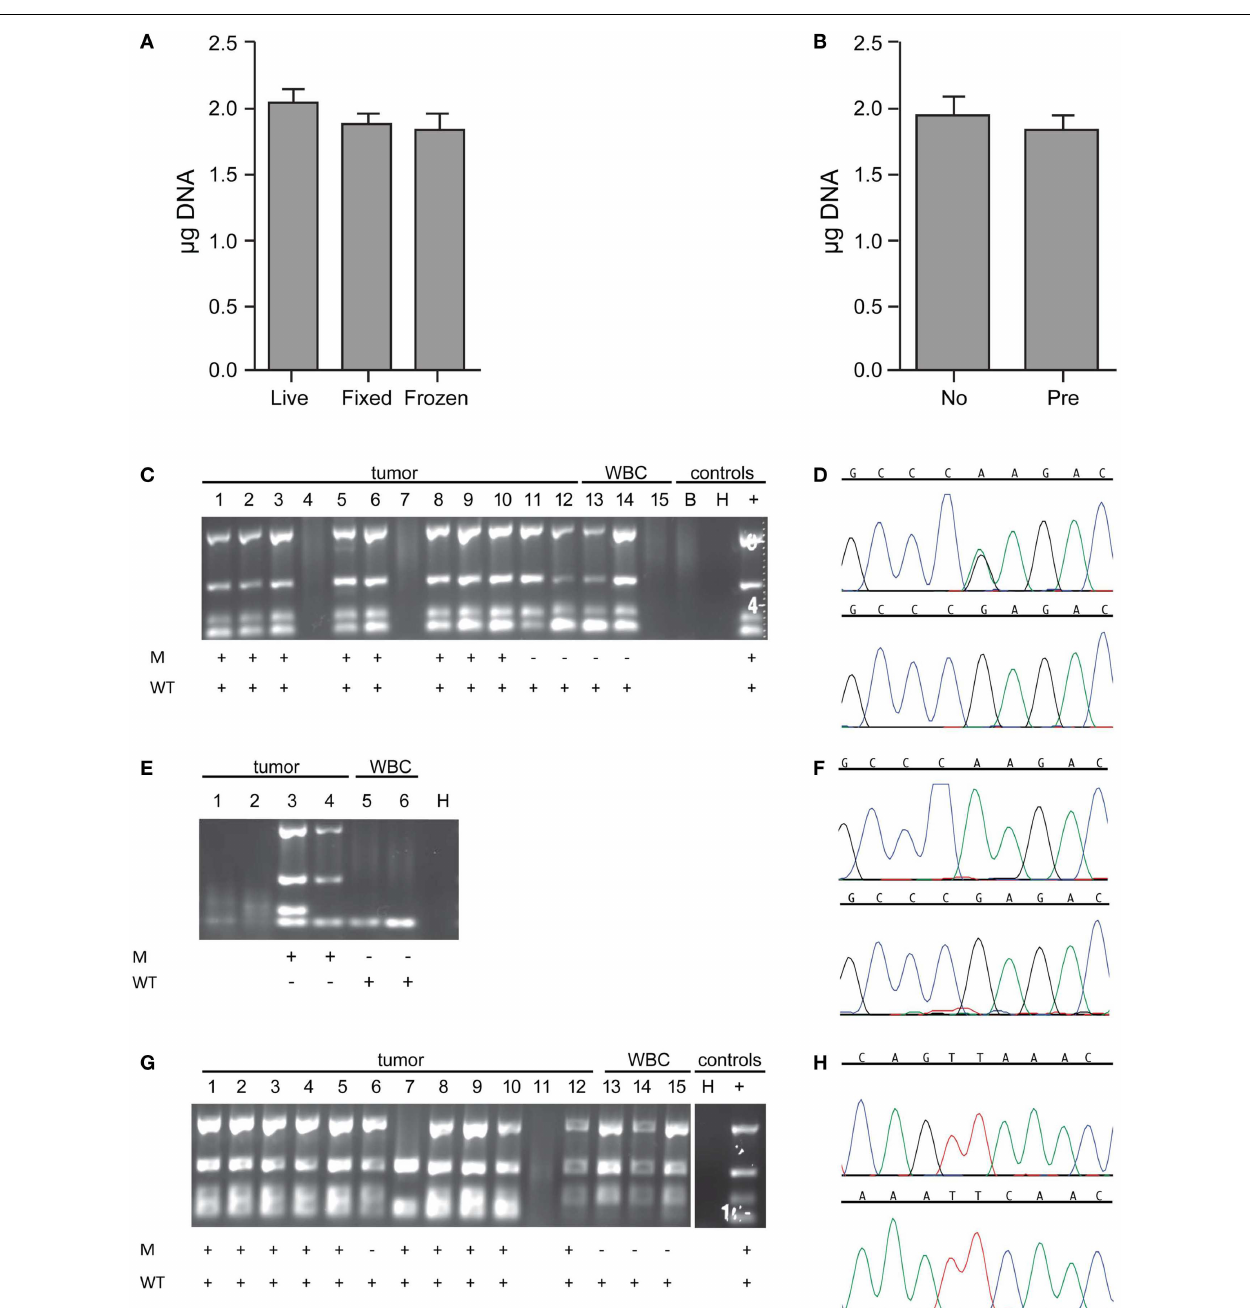
pre-labeled, single cells collected by DEPArray, DNA extracted, andWGA performed.WGA product was subjected to a quality control step in which bands for 4 housekeeping genes were visualized, as shown for 12 single heterozygous NB1643 tumor cells (columns 1–12), 3WBCs (columns 13–15), a no-cell “blank” (B), a water control (H), and positive control genomic NB1643 DNA ( + ). Detection of the mutant allele is denoted by “ + ” in row M, and detection of the wild-type allele in RowWT. (D) WGA products with one or more bands were submitted for targeted sequencing at the ALK locus. Shown are chromatograms depicting the G > A transition (R1275Q) for NB1643 cell #3 (top) and wild-type sequence forWBC#13 (below).